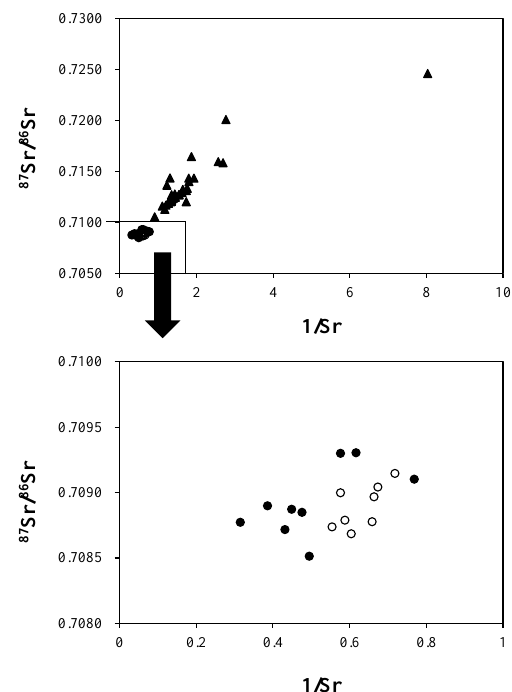
Fig. 5. Plot of the 87 Sr / 86 Sr ratios vs. 1 / Sr in the Xishui and Gui- jiang Rivers. The filled triangles represent the samples in the Gui- jiang River, and the filled and open circles represent the samples in the Xishui River in the winter and summer, respectively.